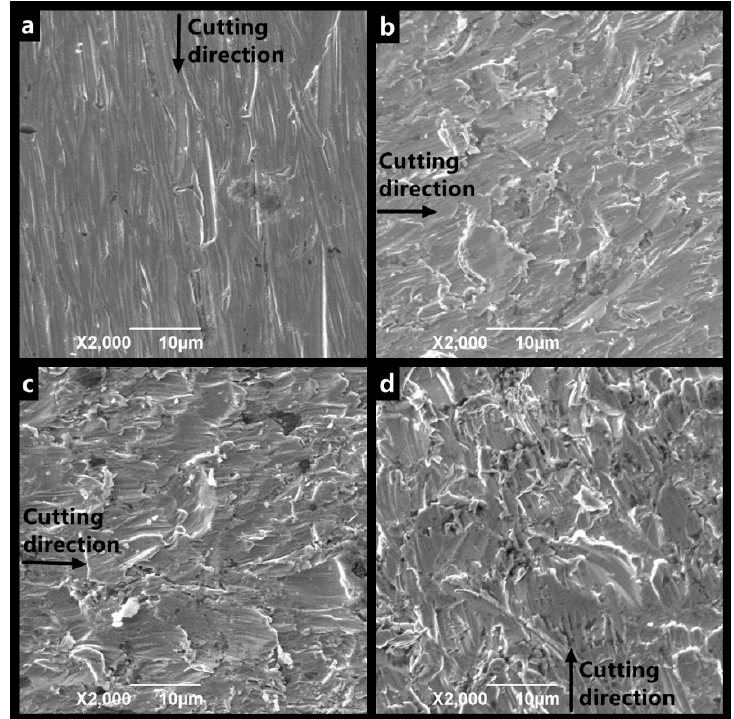
Figure 4. SEM images of 13Cr eroded at a jet velocity of 8 m/s: pure erosion at impact angle of ( a ) 30°, ( b ) 45°, ( c ) 60°, and ( d ) 90°.